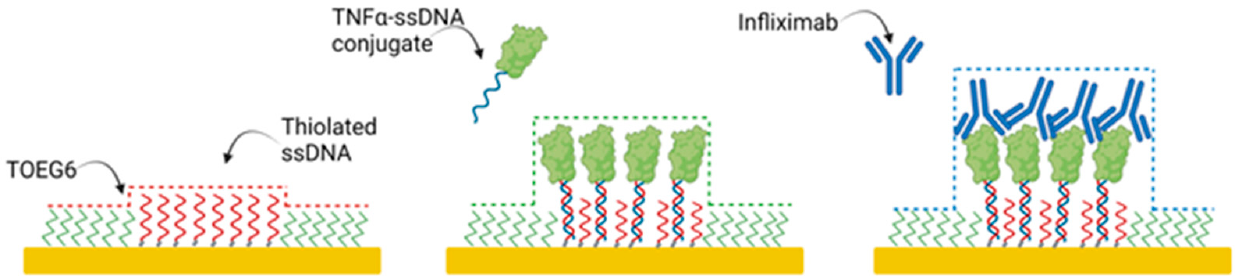
Figure 1. Infliximab measurement in an AFM-based nanoassay: a schematic representation of thiolated ssDNA patches fabricated through nanografting inside a TOEG6 carpet, TNF α -ssDNA conjugate binding, and infliximab detection. Image created with BioRender.com (accessed on 4 April 2022).